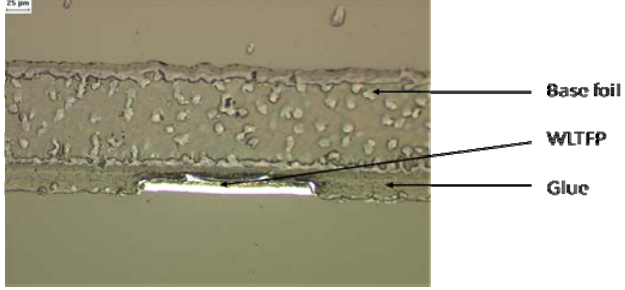
Figure 5. WLTFP embedded into the glue layer on the